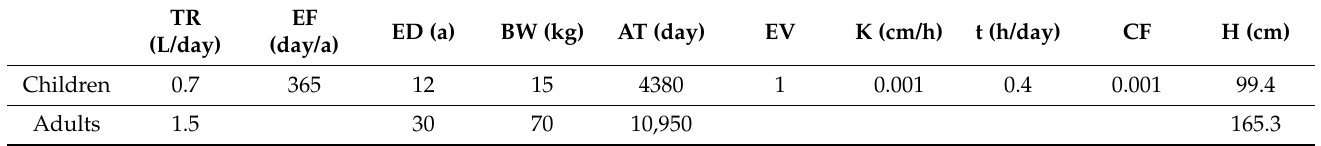
Figure 2. Research idea flowchart. Table 2. Limit values of several parameters for oral intake and skin contact by type of sensitive Table 1. Analytical methods, instruments, and detection limits of physiochemical parameters.